Question: Briefly state, in one sentence, what is plotted here.
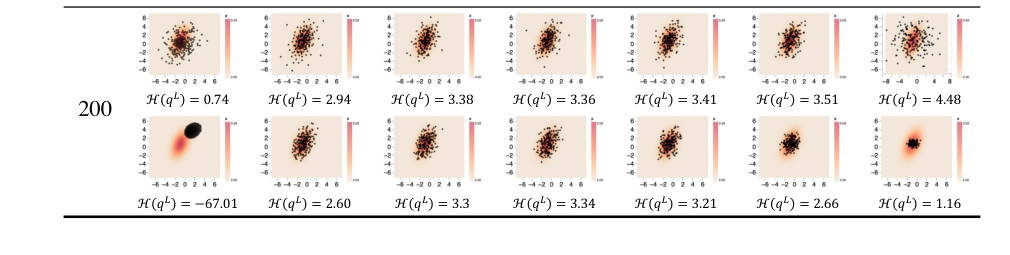
Answer: Visualization of the particles after L steps of SVGD for the different configurations of kernel variance σ and number of particles m in Figure 4b.